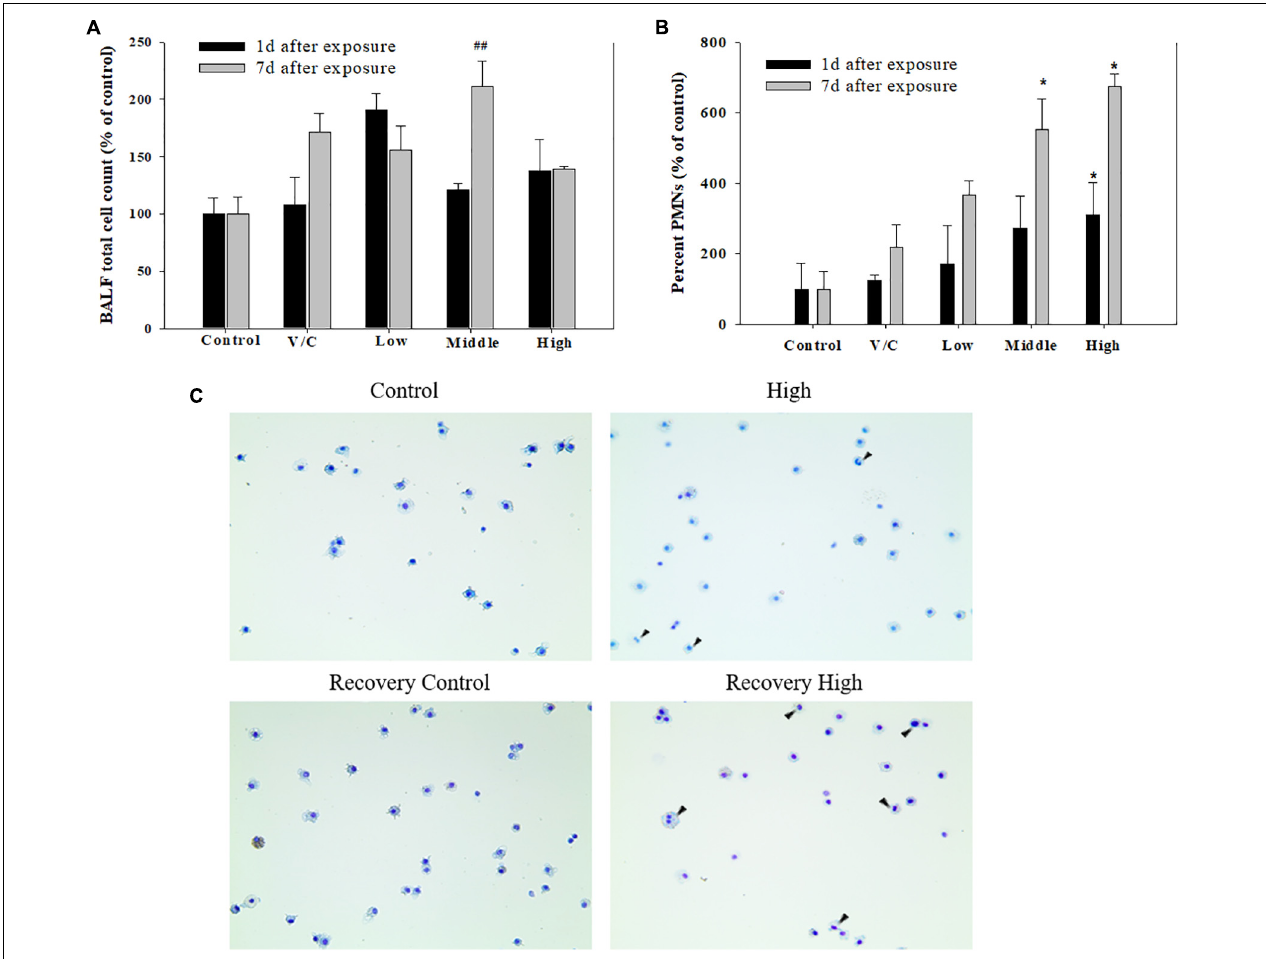
FIGURE 8 | Pulmonary inflammation induced by repeated inhalation for 2 weeks of a mixture of SM and PG in male rats. (A) Total cell count in BALF. (B) Polymorphonuclear leukocyte (PMN) count in BALF. (C) Diff-Quick staining of BALF cells. Arrowhead indicates PMNs. The values are presented as the mean ± SE (one-way ANOVA followed by Tukey’s multiple comparison test, # P < 0.05, ## P < 0.01, and ### P < 0.001, vs.